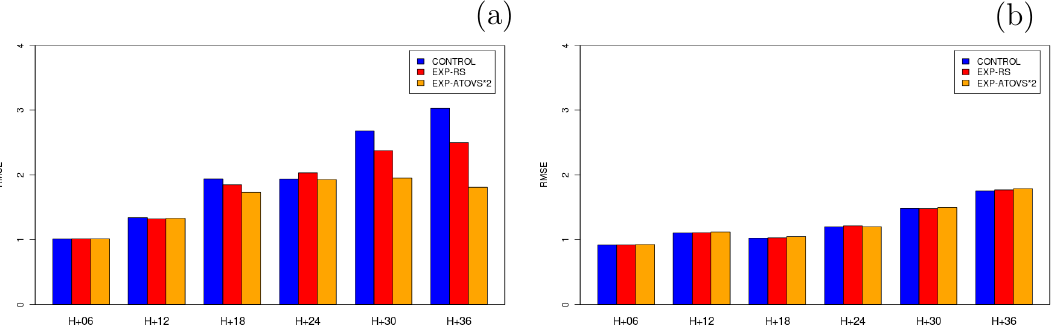
Fig. 7. RMSE for MSLP forecasts (in hPa) against forecast length for EXP, EXP-RS and EXP-ATOVS for (a) PREVIEW-DTS cases and (b) MEDEX-DTS